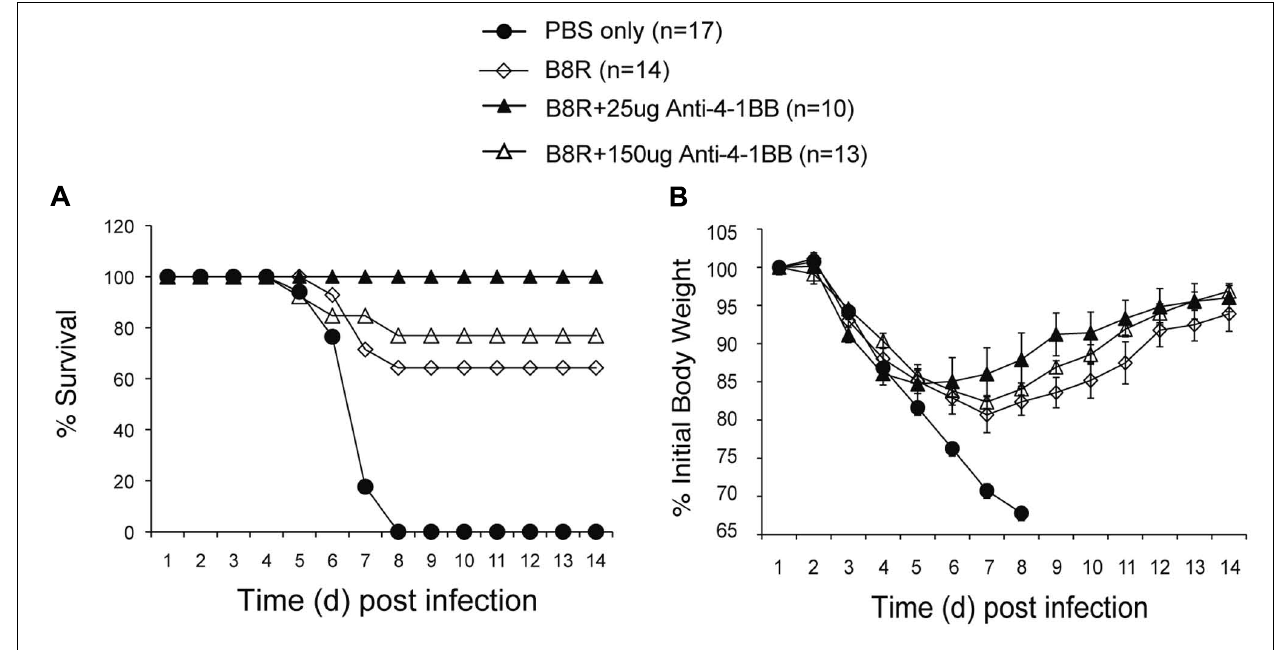
FIGURE 6 |Anti-4-1BB promotes protective CD8T cells following vaccination with an immunodominantVACV peptide. WT mice were immunized s.c. at the base of the tail with 2 μ g of B8R peptide in IFA and injected with 25 or 150 μ g anti-4-1BB antibody or rat IgG on day 1. Control groups received adjuvant but no peptide and antibody (PBS).Three weeks after vaccination, mice were infected intranasally with a lethal dose of